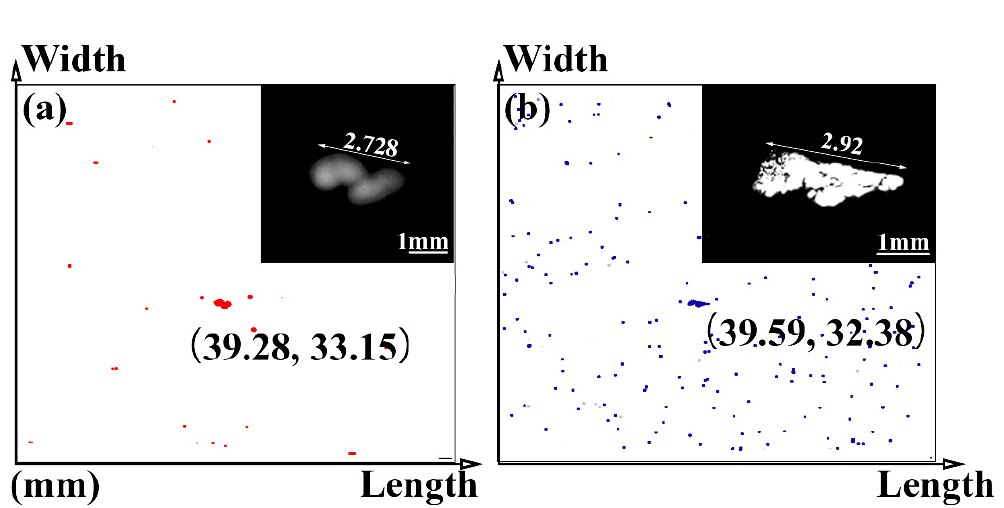
Figure 5. Comparison of size and position information of C-scanning images under different frequencies of an ultrasonic probe of ( a ) 10 MHz; ( b ) 50 MHz.